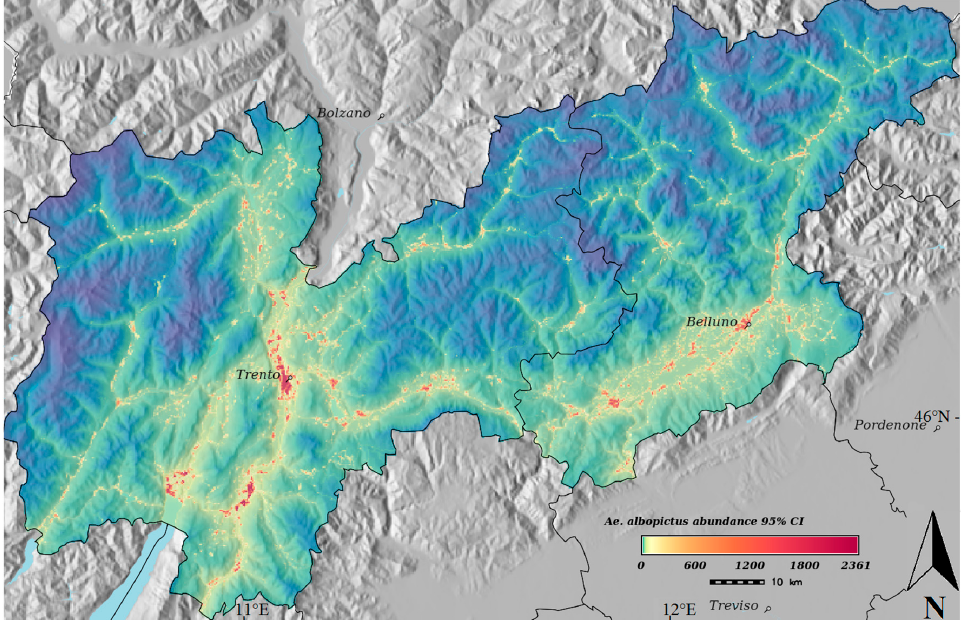
Figure 5. Map (datum: ETRS89 European Terrestrial Reference System; projection: LAEA Lambert Azimuthal Equal Area) of the simulation 95% Confidence Interval (CI) of the abundance of Aedes albopictus females (sum of eight trap nights from June to September) in the provinces of Belluno and Trento (Italy).